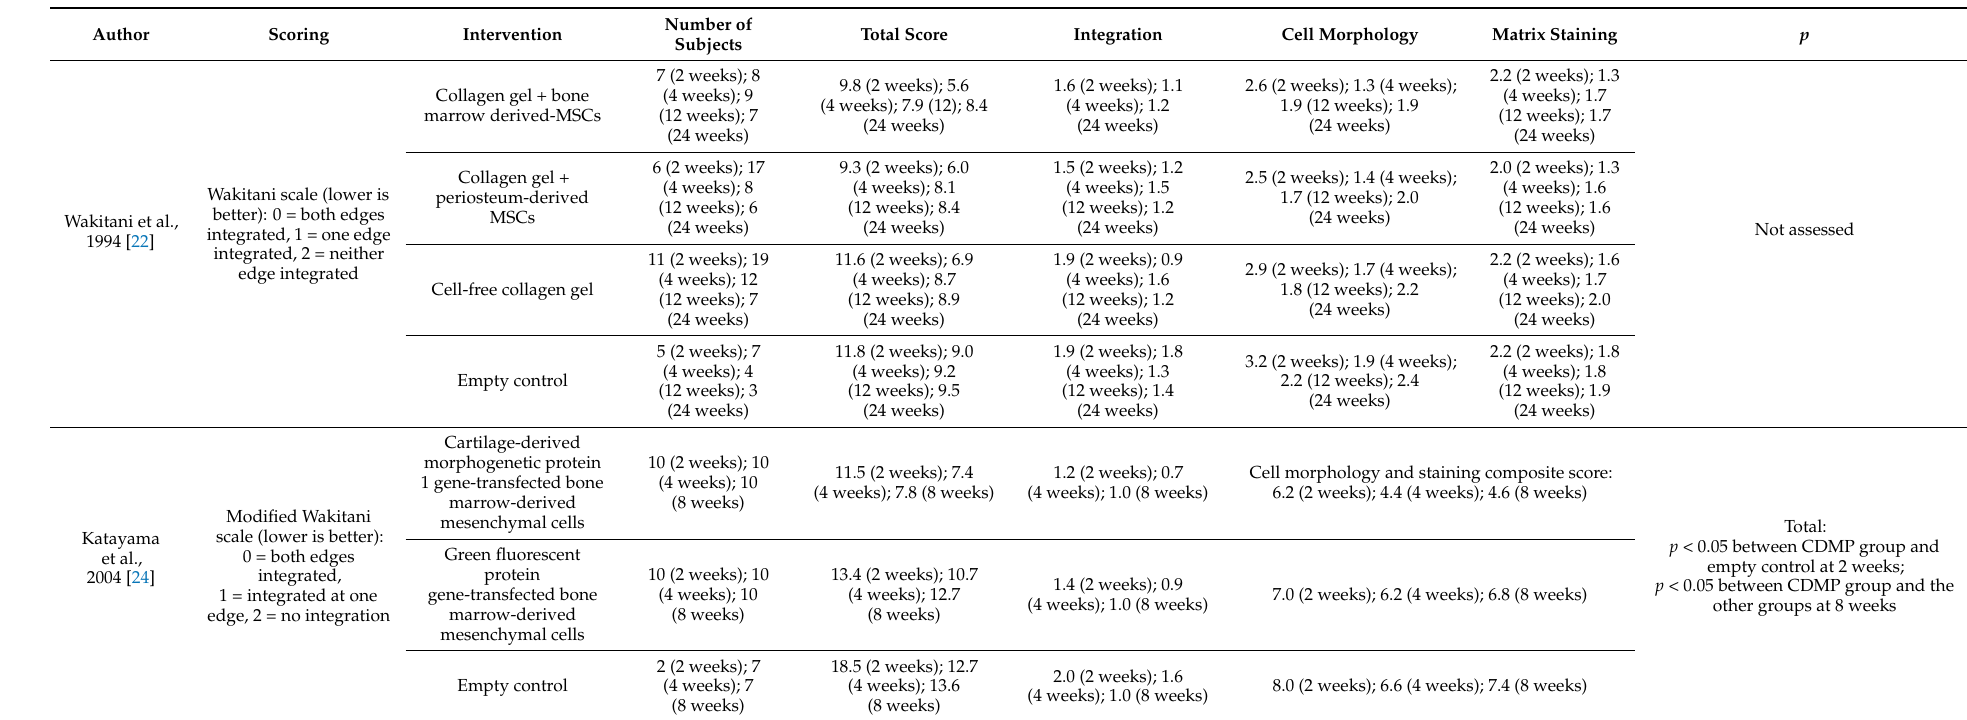
Table 2. Histology